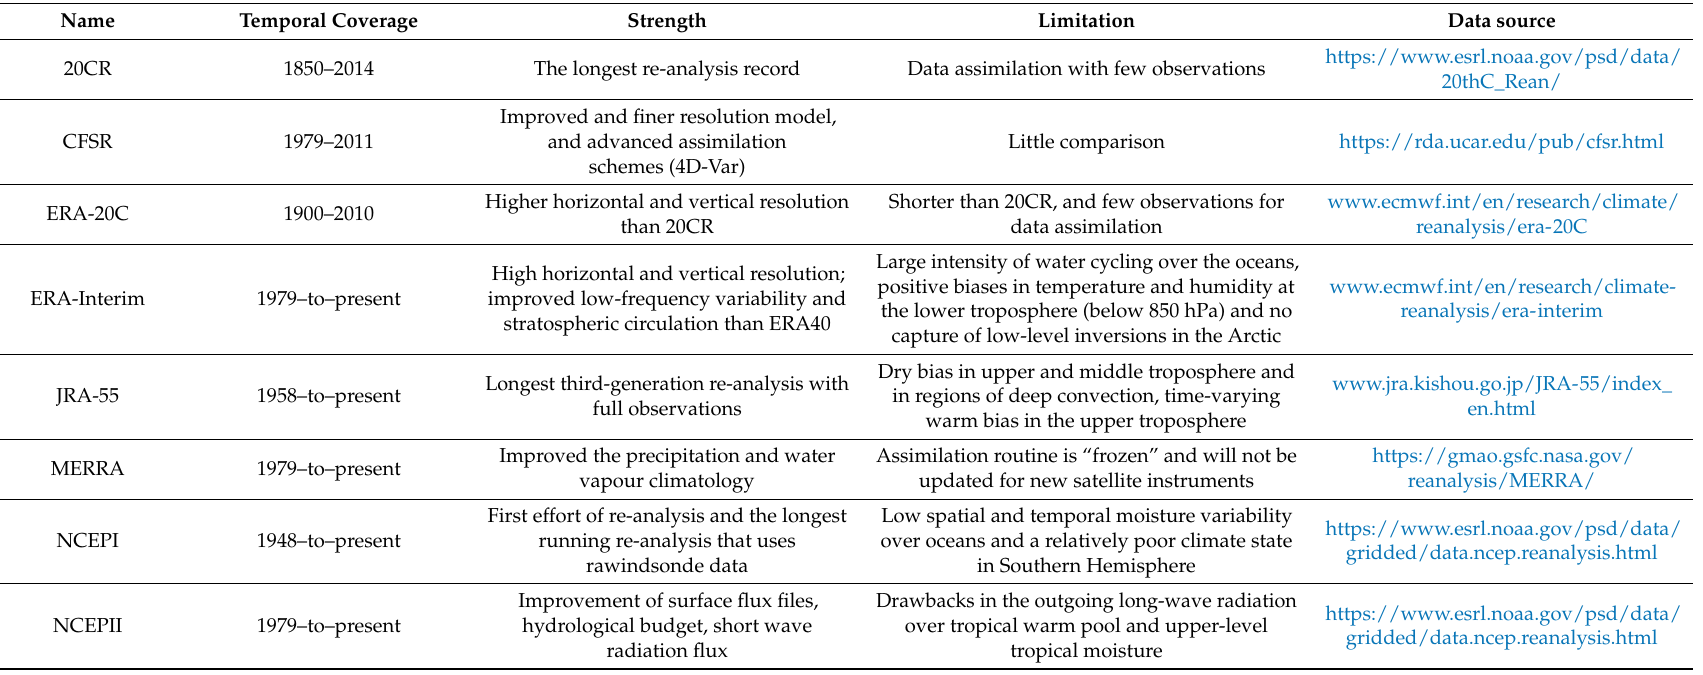
Table 2. Brief summary of the eight re-analysis datasets in this study with their strength and